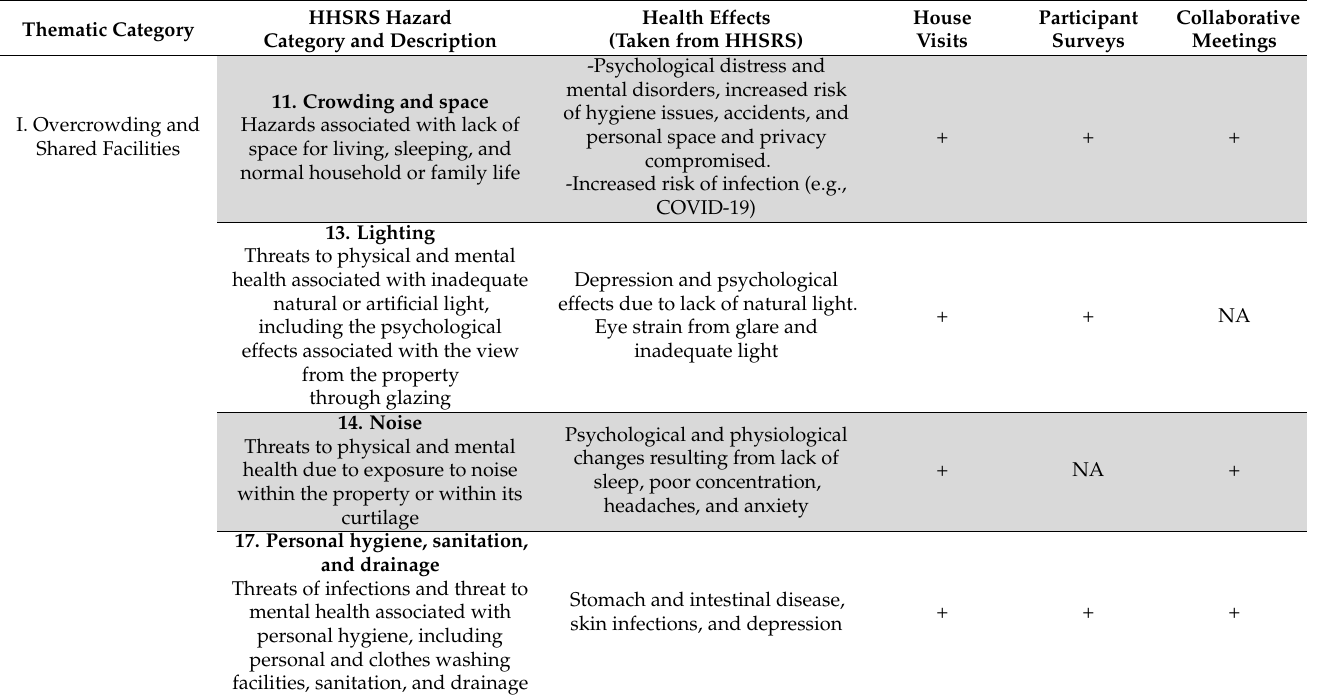
Table 3. Multi-methods triangulation of housing environment